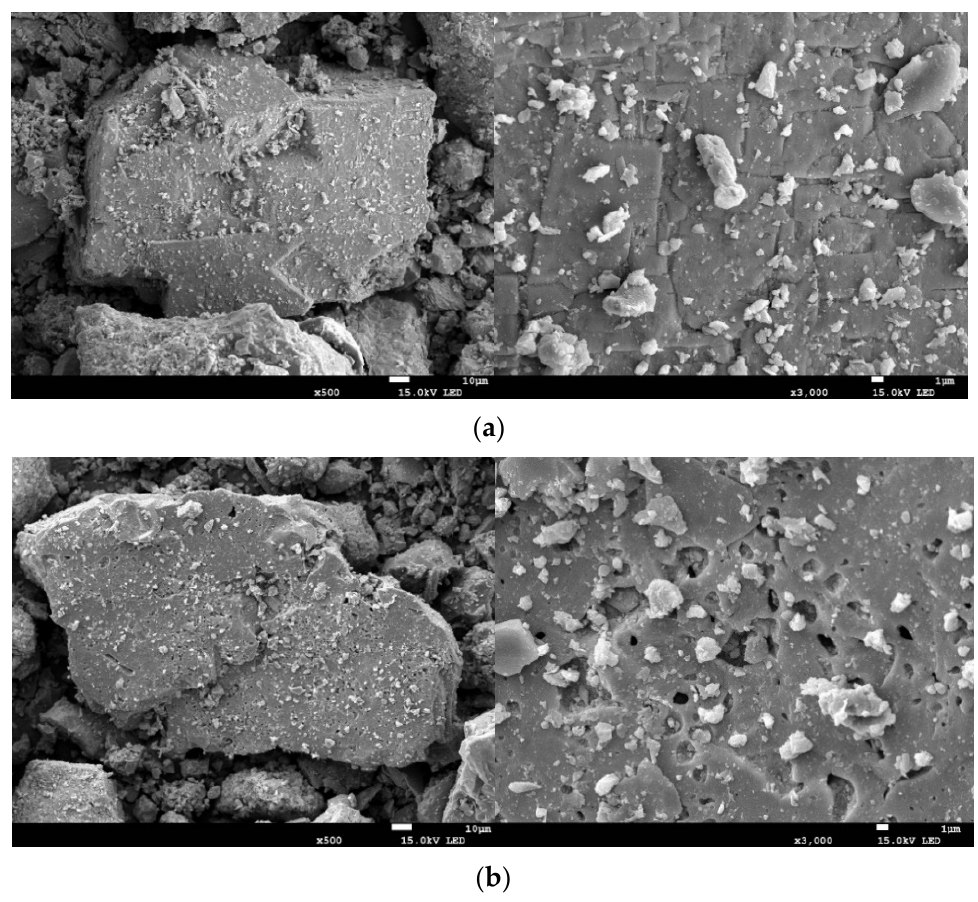
Figure 8. Scanning electron microscopic images of the ore sample before and after ultrasonic treat- ment: ( a ) untreated ore; ( b ) ultrasonically treated ore.